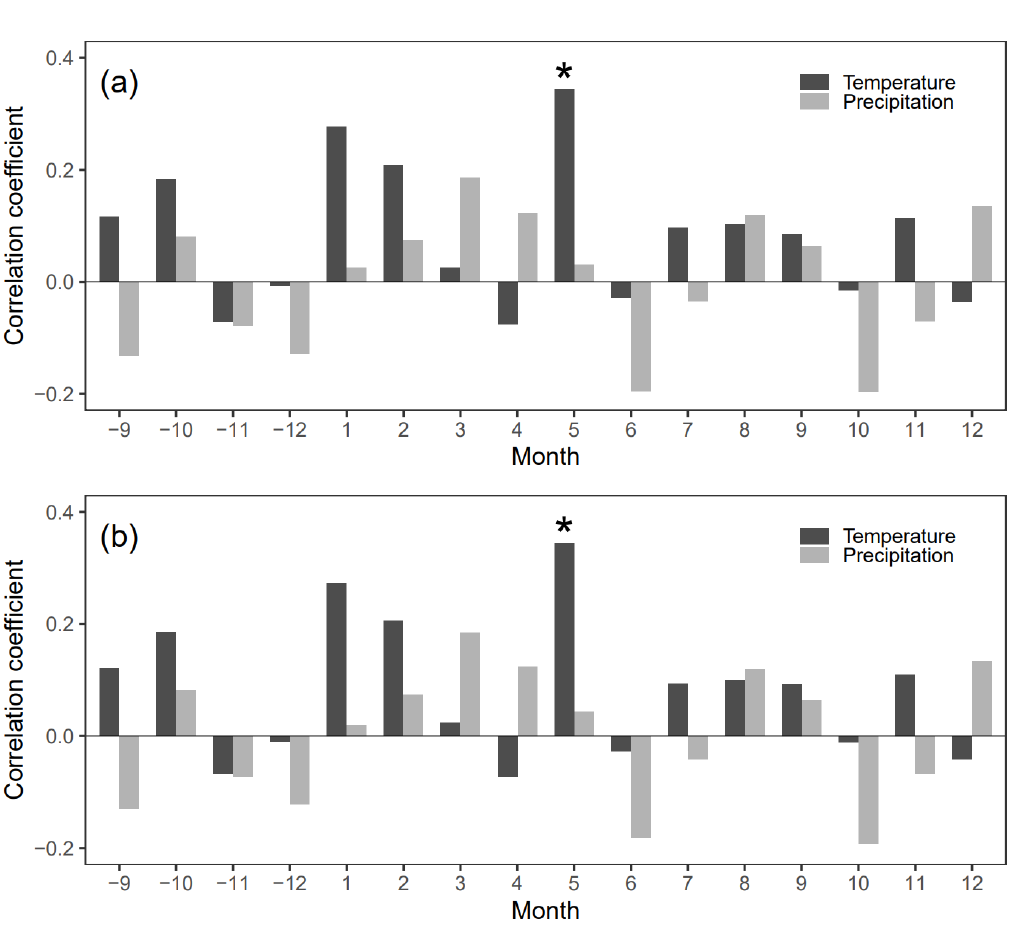
Figure A1. Correlation coefficients between ( a ) the regional chronology established by the mixed tree-ring data at three sites and ( b ) the regional chronology established by the first component (PC1; explained 76% of the total variance) of the principal component analysis (PCA) of the chronologies at three sites and the climatic data during 1966 – 2018. Asterisk denotes that the correlation between the two variables is significant at the 95% confidence level ( p < 0.05).